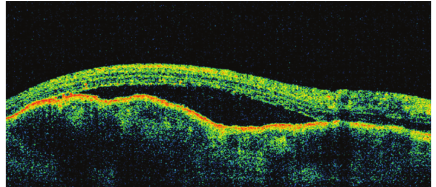
Figure 3: At diagnosis, optical coherence tomography of the left eye demonstrated a dome-shaped elevation of both the neurosensory retina and retinal pigment epithelium- (RPE-) Bruch reflectivity associated with subretinal fluid.